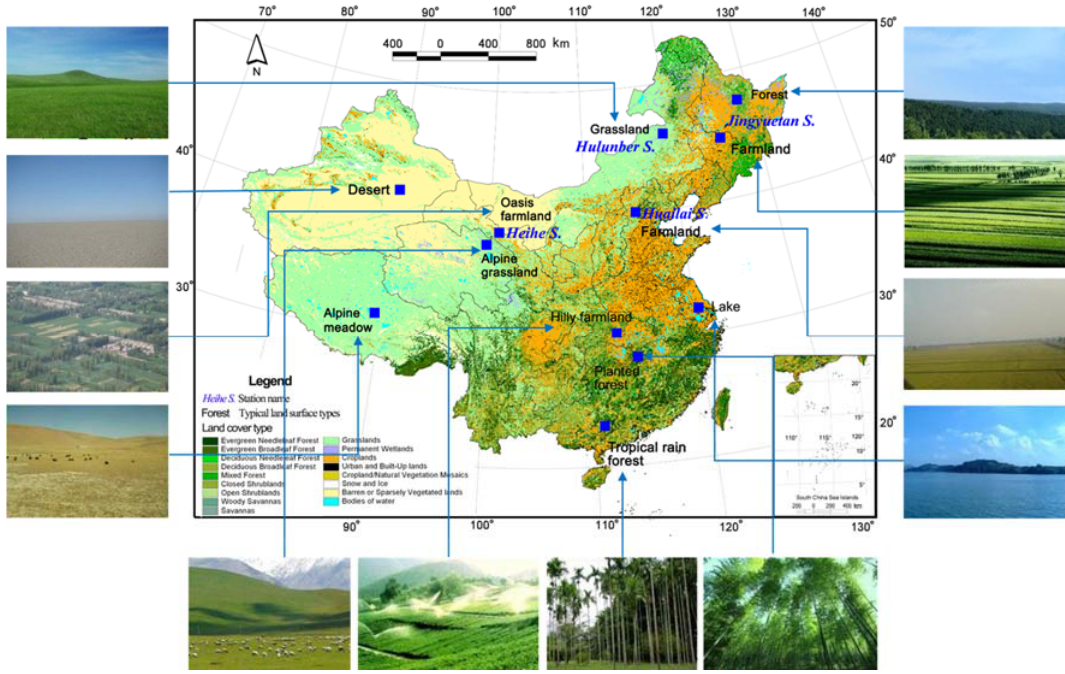
Figure 4. Sketch map of anchor sites in the validation network [169].